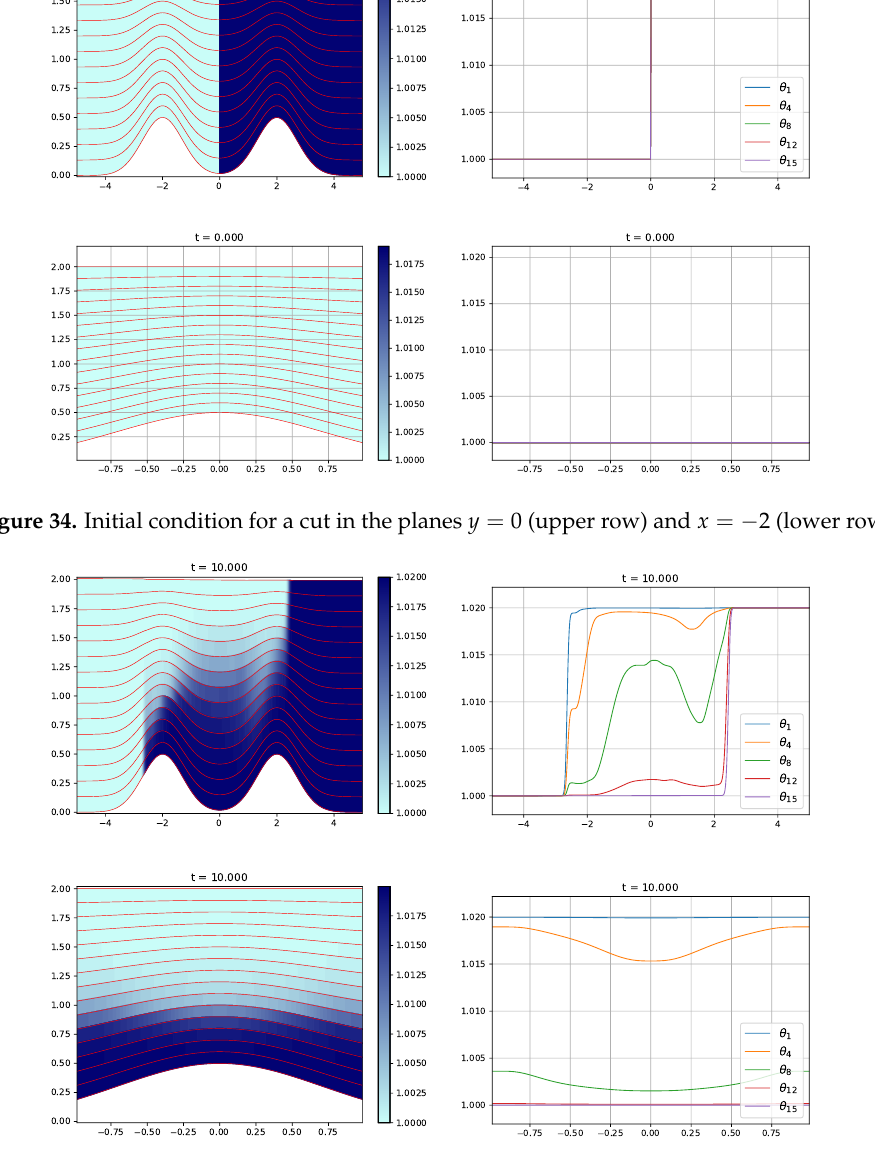
Figure 35. Distribution of θ for a cut in the plane y = 0 (upper row) and x = − 2 (lower